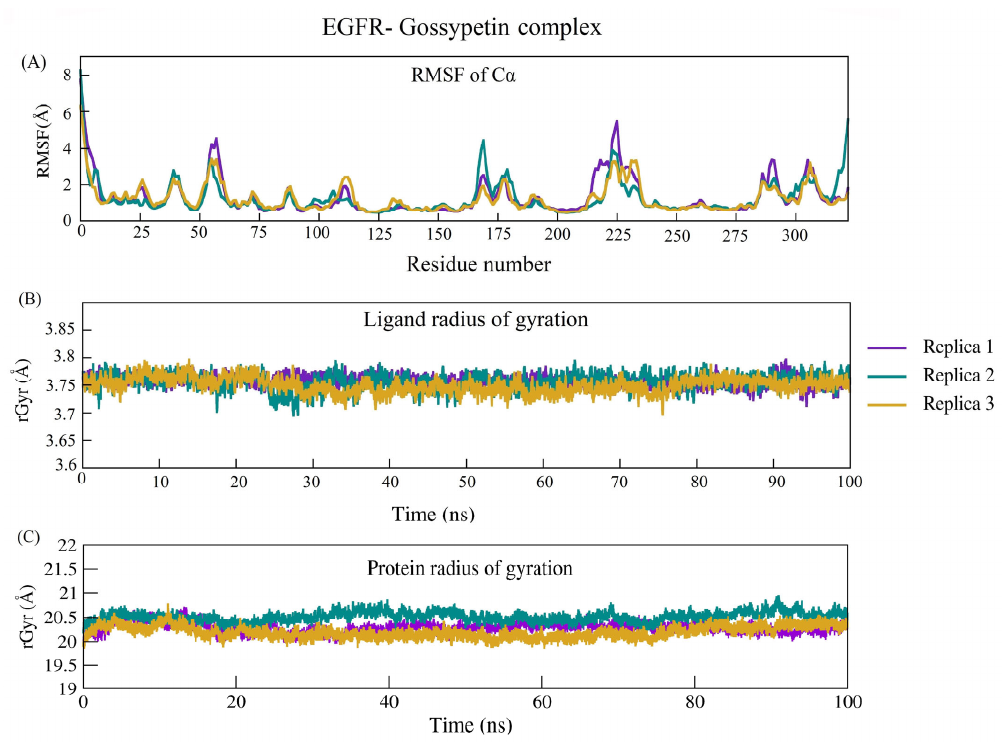
Figure 10. EGFR–Gossypetin complex 100 ns MD production run. ( A ) Protein RMSF plot. ( B ) Gyration plot depicting the extendedness of a ligand. ( C ) Gyration plot of protein during a 100 ns production run.